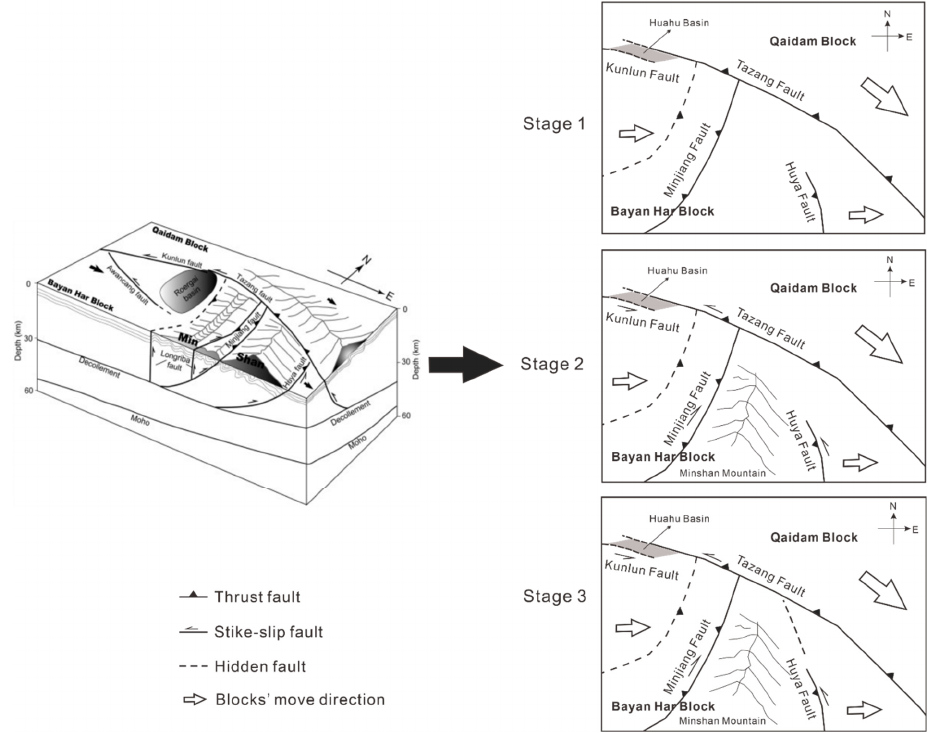
Figure 21. Block diagram of the eastern termination of the Kunlun fault. Modified from Ren et al., 2013b [34]. The crustal structure is from deep seismic reflection results. Black arrows show the direction of block motion relative to Eurasia.